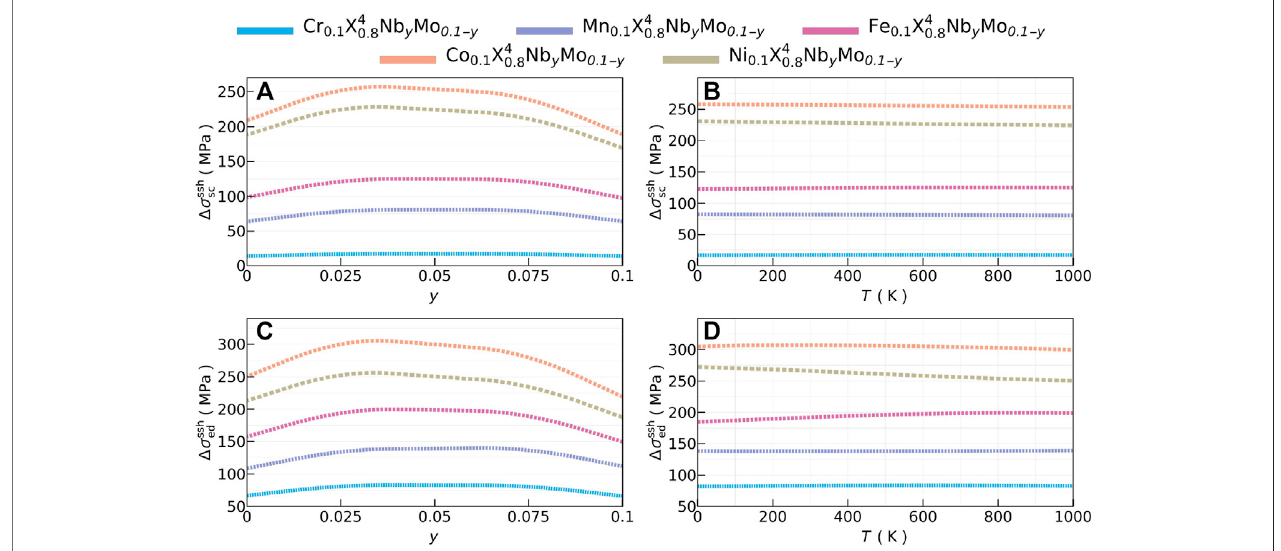
FIGURE 6 | Composition dependence at T (cid:1) 1000 K and temperature dependence at y (cid:1) 0.05 of solid-solution hardening (in MPa units) due to Nb and Mo substitution for screw ( Δ σ ssh sc ) (A,B) , respectively) and edge ( Δ σ ssh ed ) (C,D) , respectively) dislocations, for which theory-dependent α parameters were set to 4 and 16,